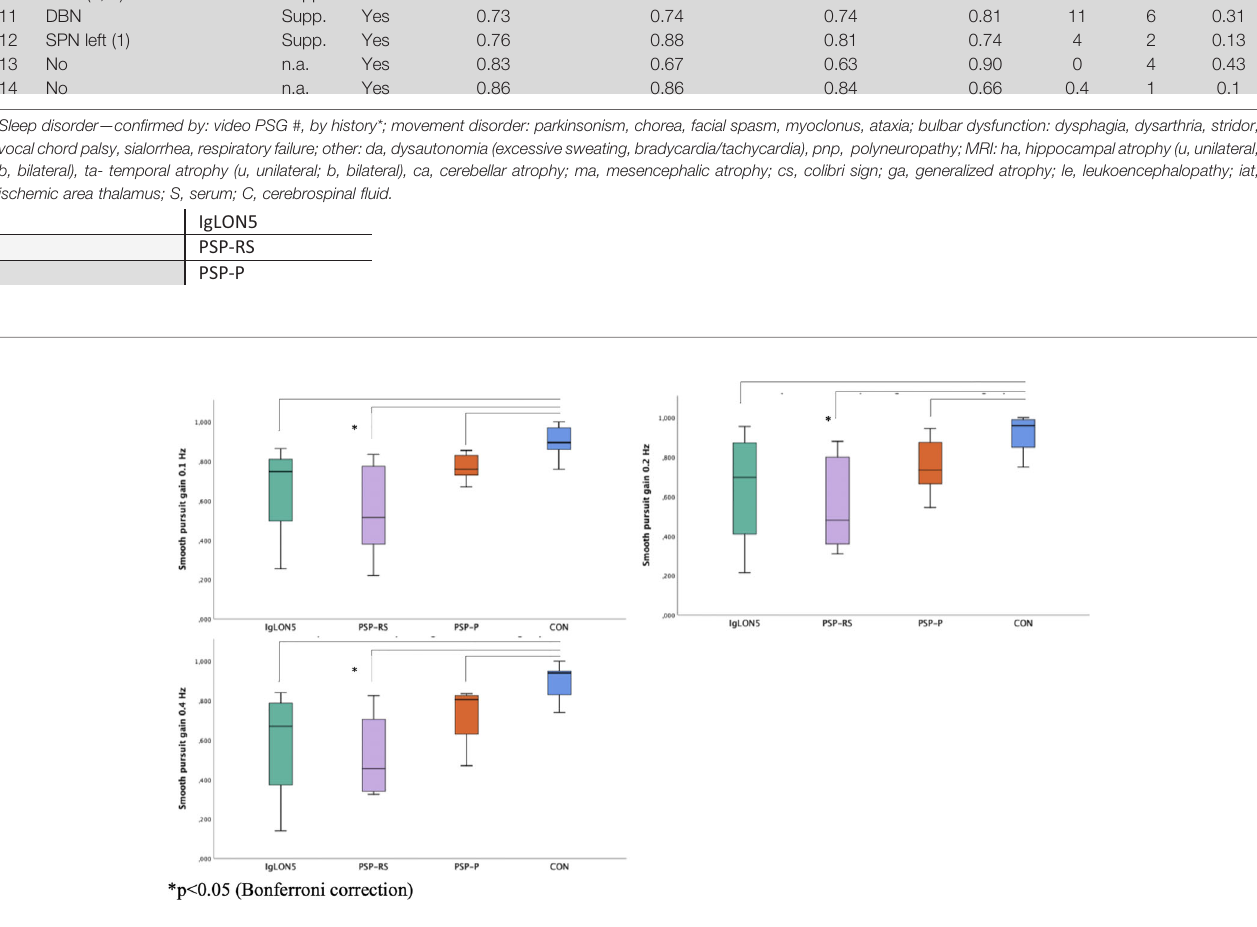
FIGURE 3 | Smooth pursuit gain at 0.1 Hz, 0.2 Hz, 0.4